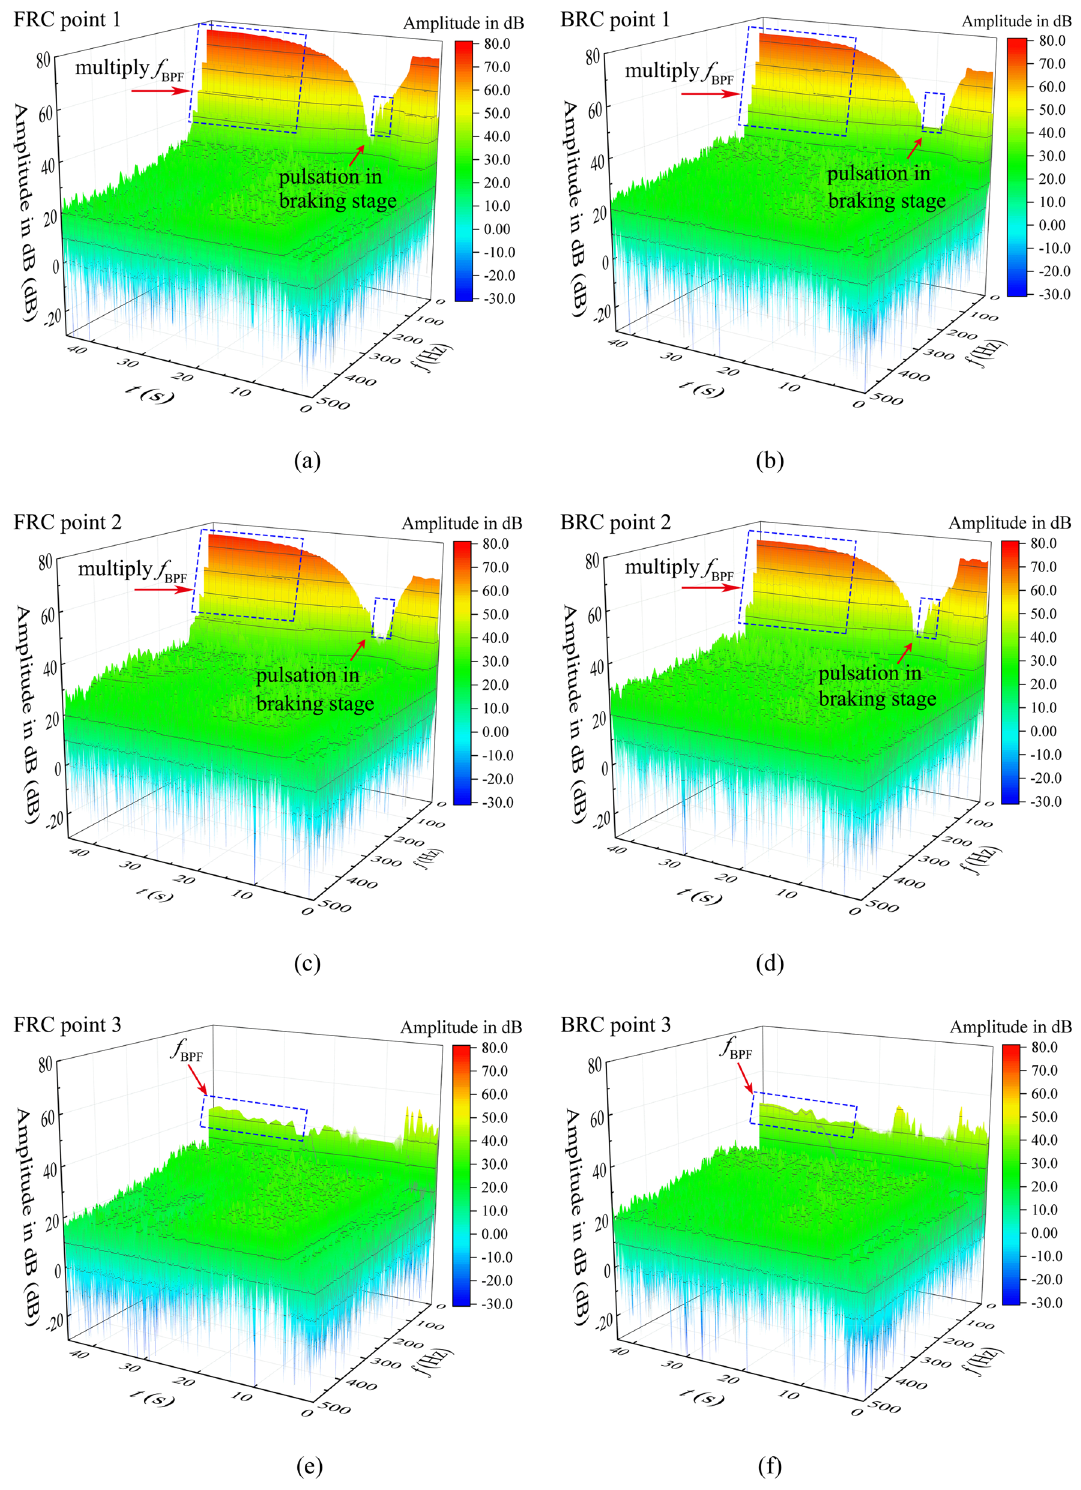
Figure 12. The Transient frequency domain diagram of pressure fluctuation at monitoring points, ( a ) point 1 under FRC, ( b ) point 1 under BRC, ( c ) point 2 under FRC, ( d ) point 2 under BRC, ( e ) point 3 under FRC, ( f ) point 3 under